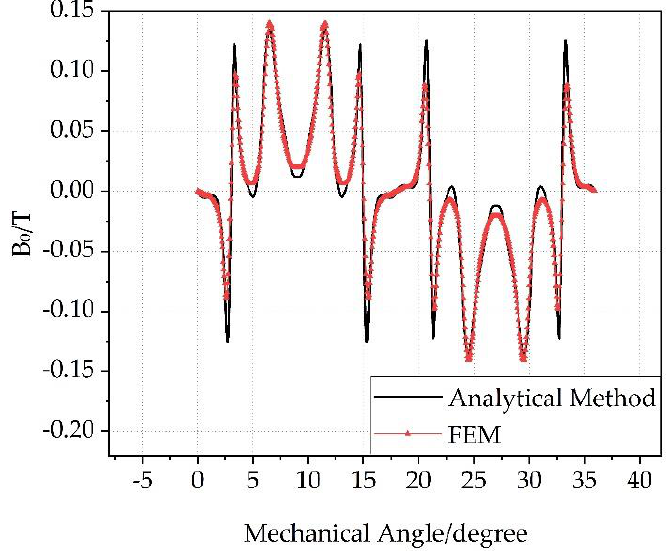
Figure 13. Comparison of the tangential component of magnetic field of slotted model.